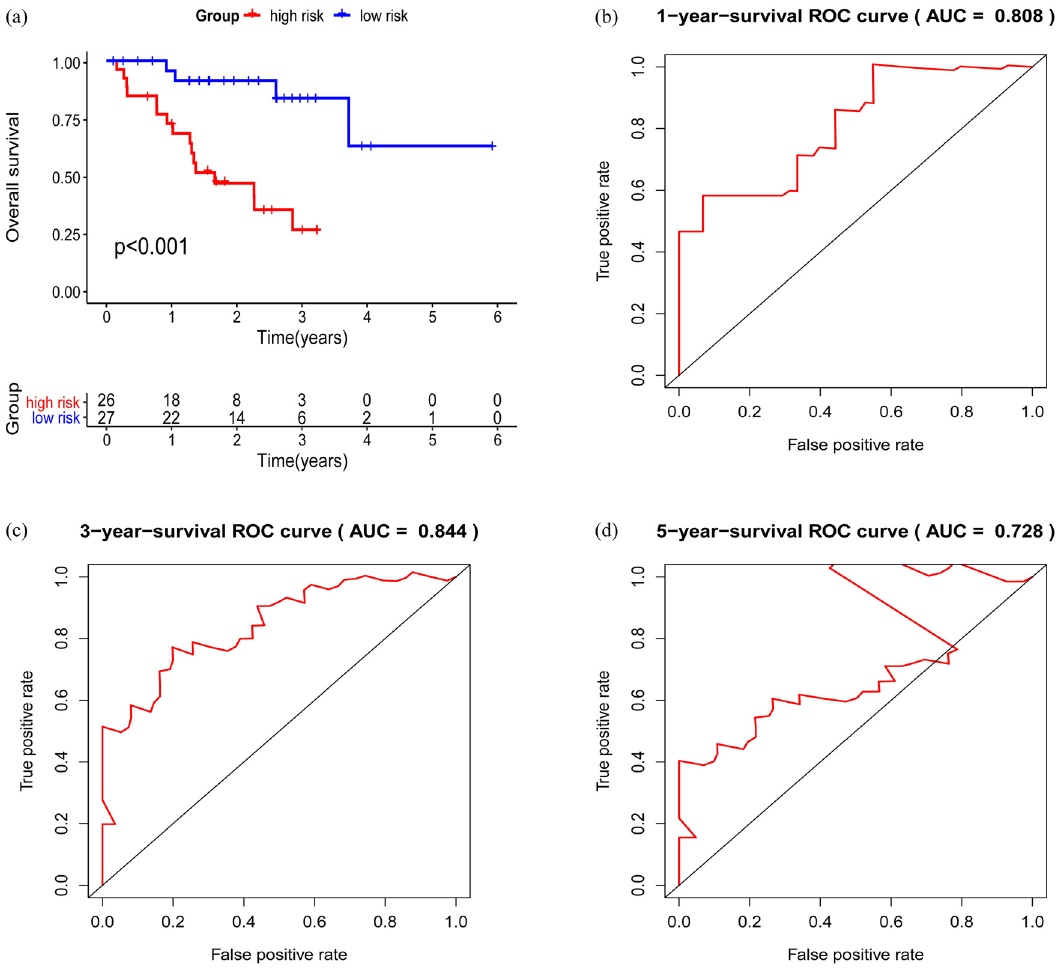
Figure 8: The ROC curve assess the predictive ability of the risk model at di ff erent endpoints ( 1, 3, and 5, years )